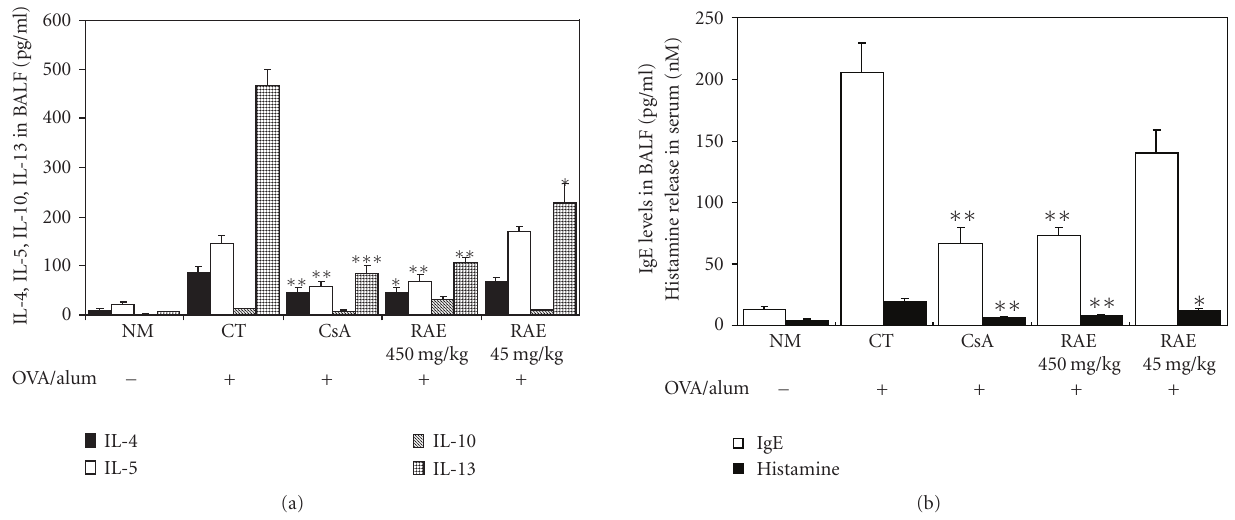
Figure 7: E ff ect of RAE on cytokines, immunoglobulin E levels in BALF and histamine release in serum (NM: normal C57BL/6 mice; CT: OVA-induced asthma mice (control); CsA: OVA-induced asthma mice treated with cyclosporine A (10mg/kg); RAE 450 mg/kg: OVA- induced asthma mice treated with RAE (450mg/kg); RAE 450 mg/kg: OVA-induced asthma mice treated with RAE (450mg/kg)).